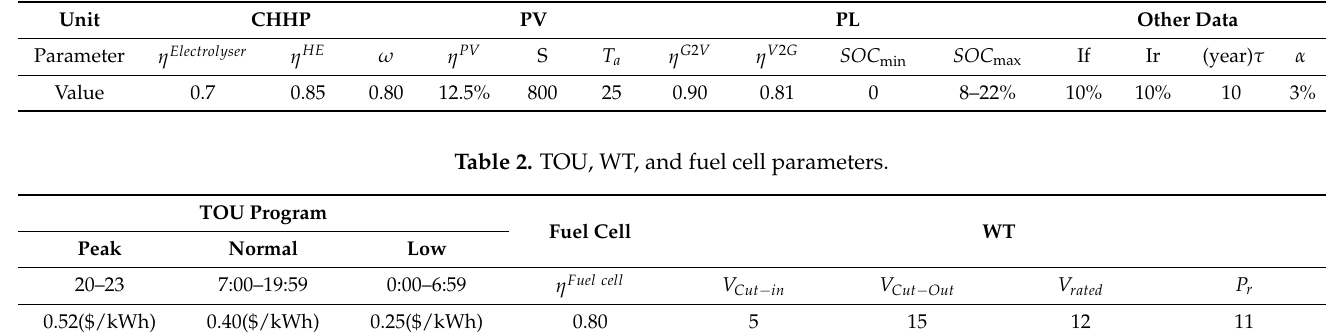
Table 1. PV, PL, and CHHP parameters.